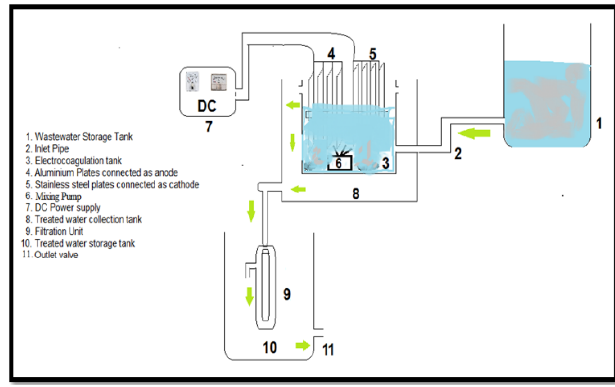
Fig. 1. Design structure of electrocoagulation treatment unit